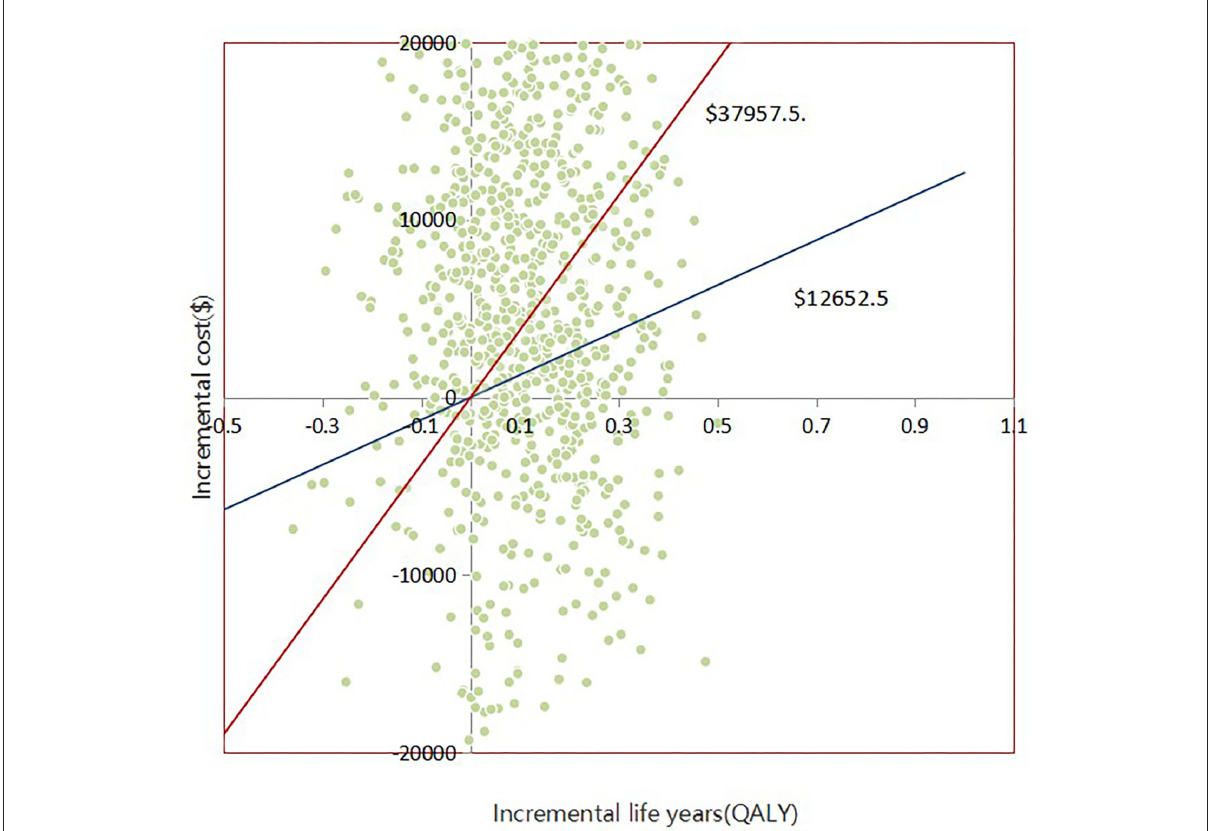
FIGURE3 Scatter plot showing the incremental costs and incremental quality-adjusted life-year of a thousand simulations for Empagliflozin group and Control